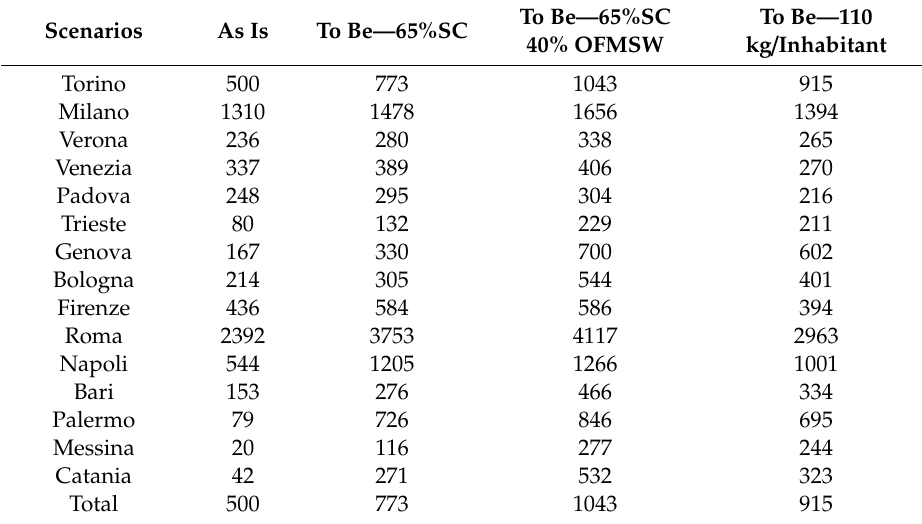
Table 8. Potential biomethane productivity (m 3 /